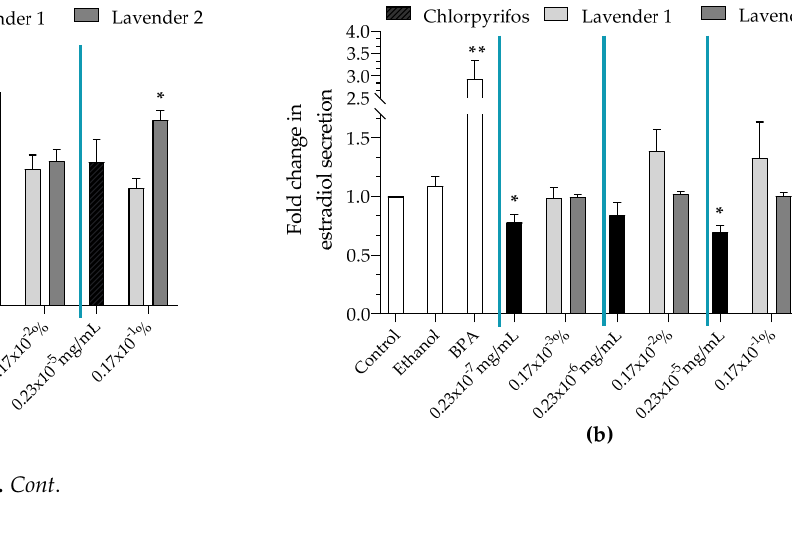
Figure 2. Quantification of the release of ( a ) progesterone, ( b ) estradiol, ( c ) h ‐ hCG and ( d ) hPL after incubation of JEG ‐ Tox cells with chlorpyrifos 0.23 × 10 − 7 mg/mL, 0.23 × 10 − 6 mg/mL and 0.23 × 10 − 5 mg/mL or two lavender EOs (1 and 2) at 0.17 × 10 − 3 %, 0.17 × 10 − 2 % and 0.17 × 10 − 1 % for 72 h. AP at 10 μ M, BPA at 20 μ M, DES at 3.75 μ M was used as a positive control. The significance levels were * p < 0.1 and ** p < 0.01. 3.4. P2X7 Receptor Activation P2X7 pore opening, reflecting P2X7 receptor activation, was assessed using the fluo ‐ rescent YO ‐ PRO ‐ 1 ® assay. Two lavender EOs had no effect on P2X7 receptor activation, while chlorpyrifos statistically activated the P2X7 receptor at 0.23 × 10 − 6 mg/mL and 0.23 × 10 − 5 mg/mL (x1.17 and x1.16, respectively, Figure 3).